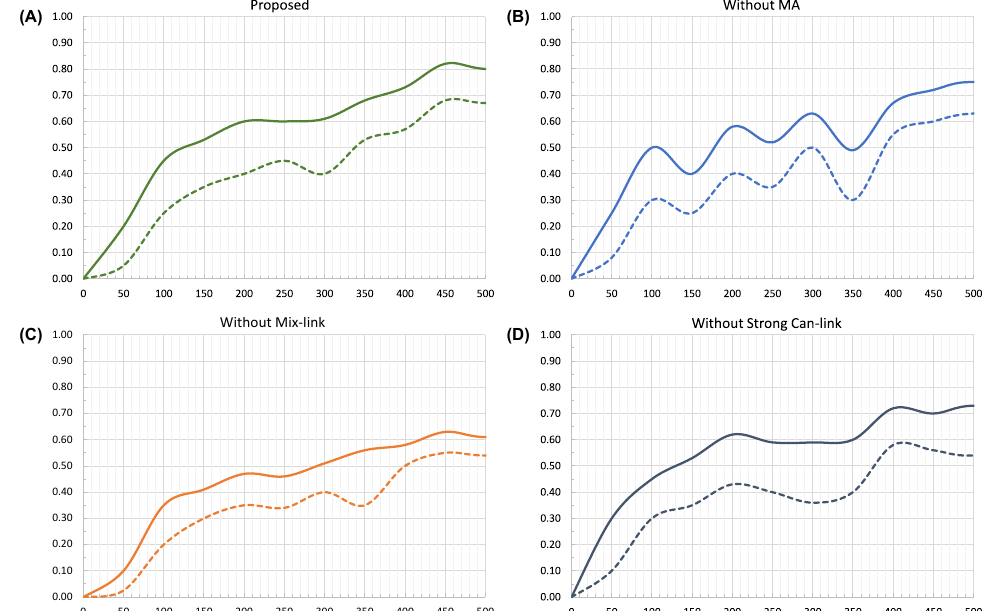
Figure 6. The figure illustrates the CACC (solid line) and ARI (dashed line) of the model while training. The graphs highlight the training benchmark without moving average (MA) weights ( B ), without mix-links ( C ), without strong can-link pairs ( D ), and the proposed model ( A ). The horizontal and vertical axis represents epochs and metric performance,